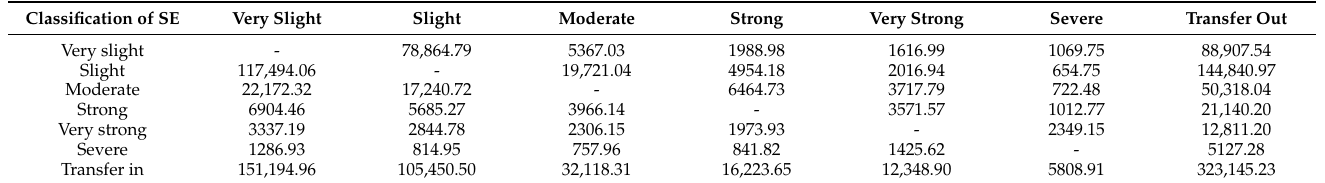
Table 4. Soil erosion transfer matrix for the Yellow River Basin derived from data from 2000 to 2020 (km 2 ).